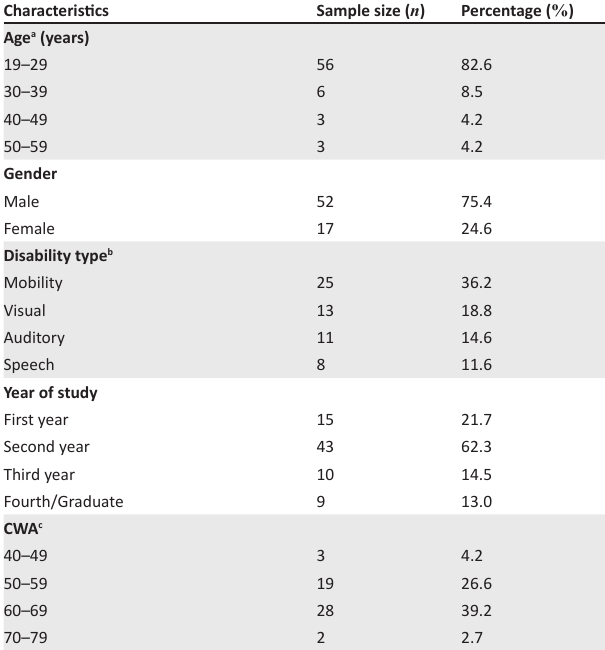
TABLE 1: Demographic characteristics of participants ( N =